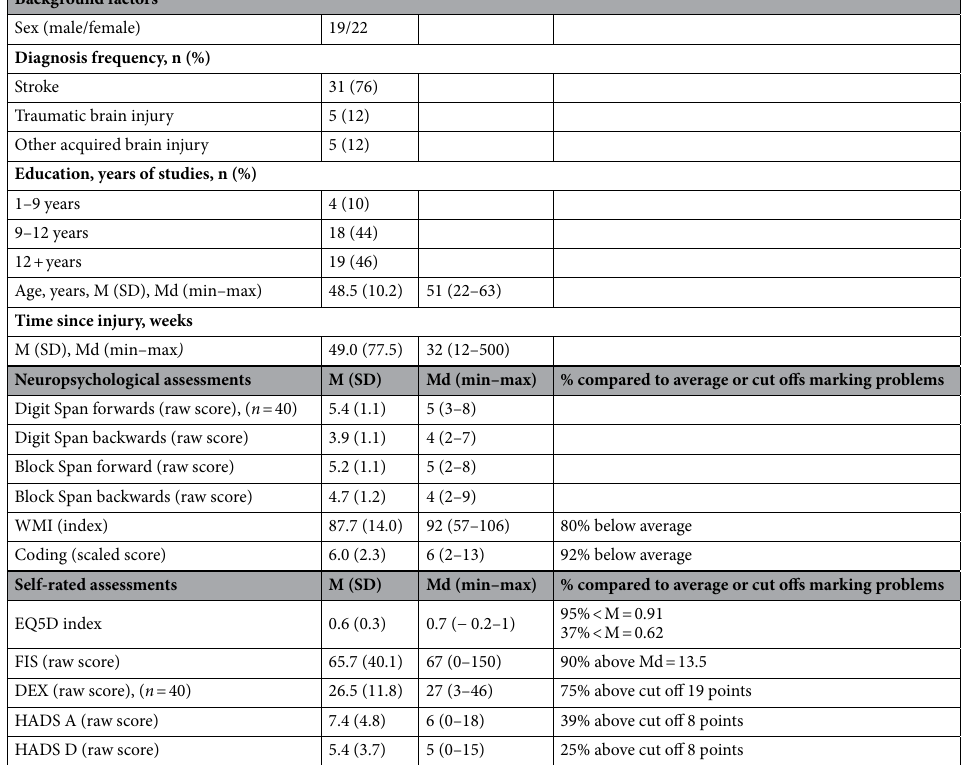
Table 1. The characteristics of the participants with acquired brain injury (n = 41), background factors, neuropsychological and self-rated assessments. N participants, M mean, SD standard deviation, Md median, min–max minimum–maximum. Assessments: Digit Span, Block Span, WMI (index of Digit Span, Arithmetics, and Letter Number Sequencing) and Coding from the WAIS-III NI Wechsler Adult Intelligence Scale